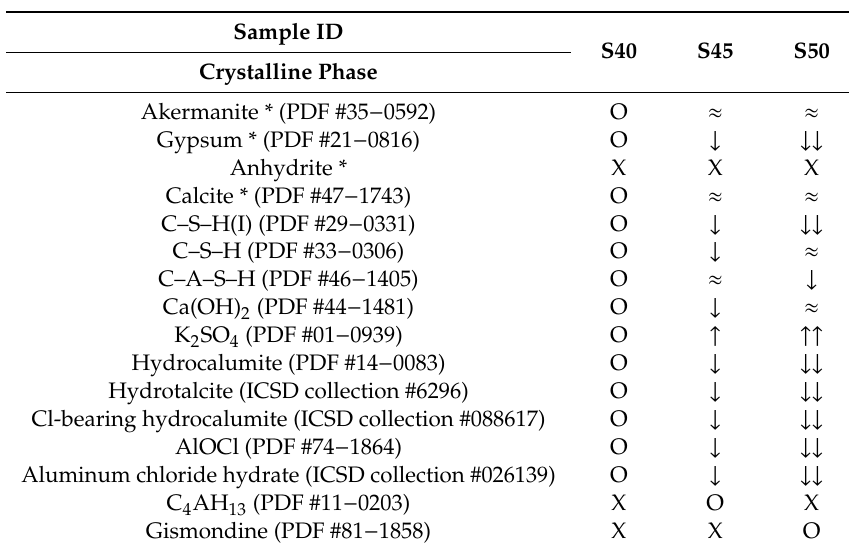
Figure 7. XRD patterns of seawater-mixed AAS pastes with di ff erent a / b ratios. Table 6. Phase change in the XRD pattern in Figure